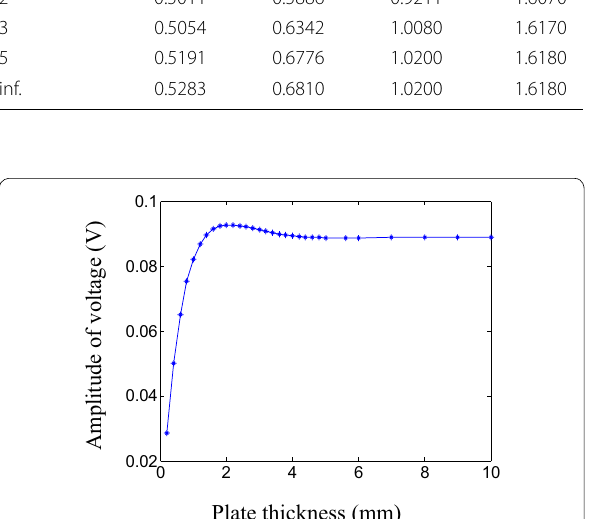
Figure 7 Relation between coil voltage due to EC and plate thickness